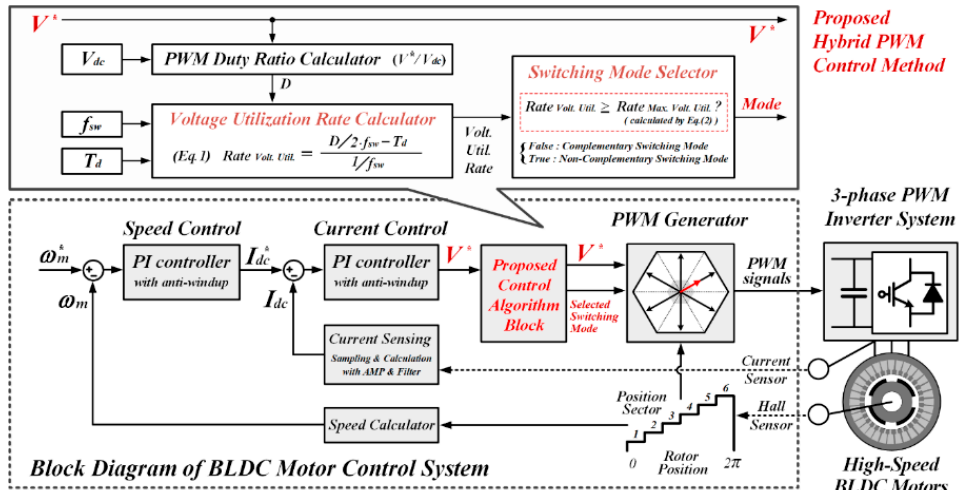
Figure 4. Block diagram of the BLDC motor control system with the proposed control algorithm. V* is the value of reference voltage for the PWM control. This value is output from the current controller and used for PWM